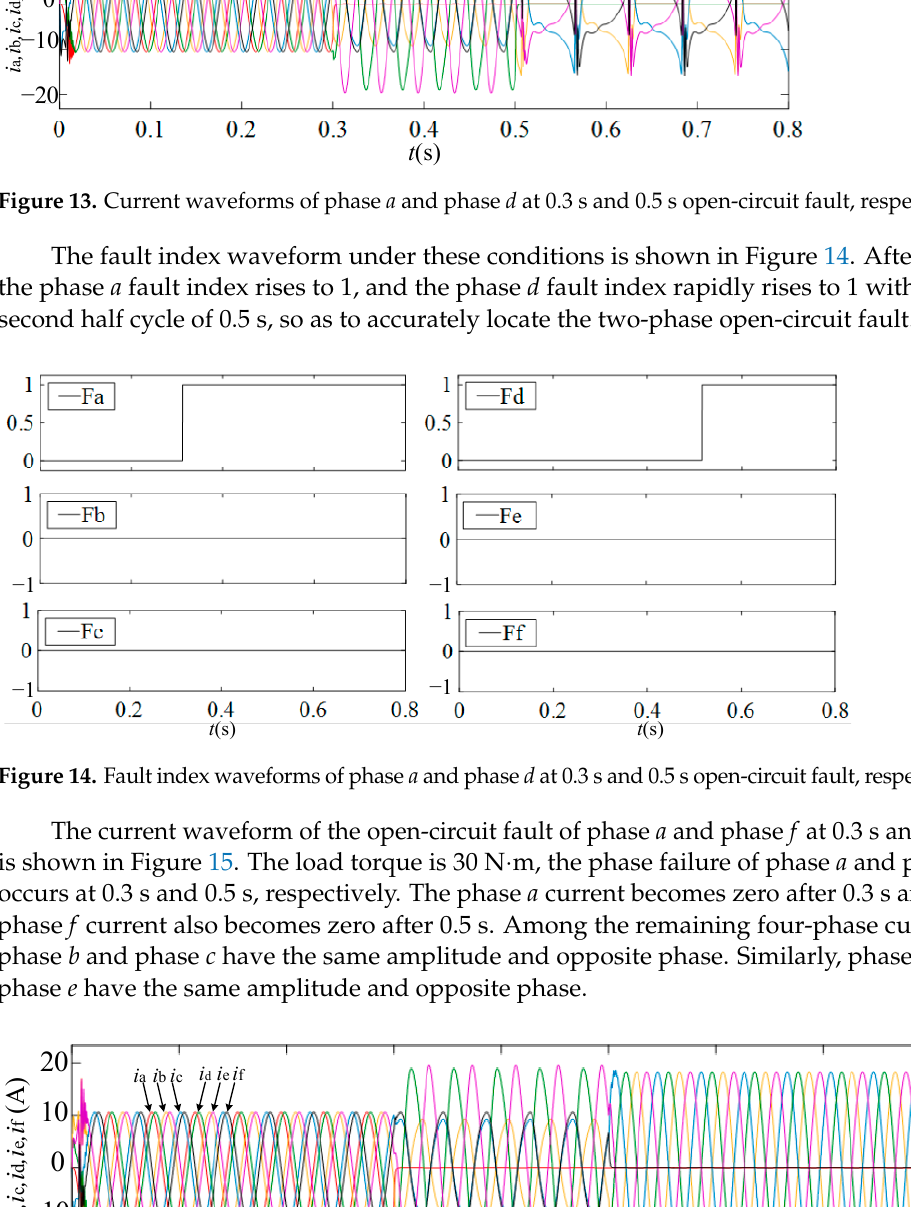
Figure 15. Current waveforms of phase a and phase f at 0.3 s and 0.5s open-circuit fault, respectively.